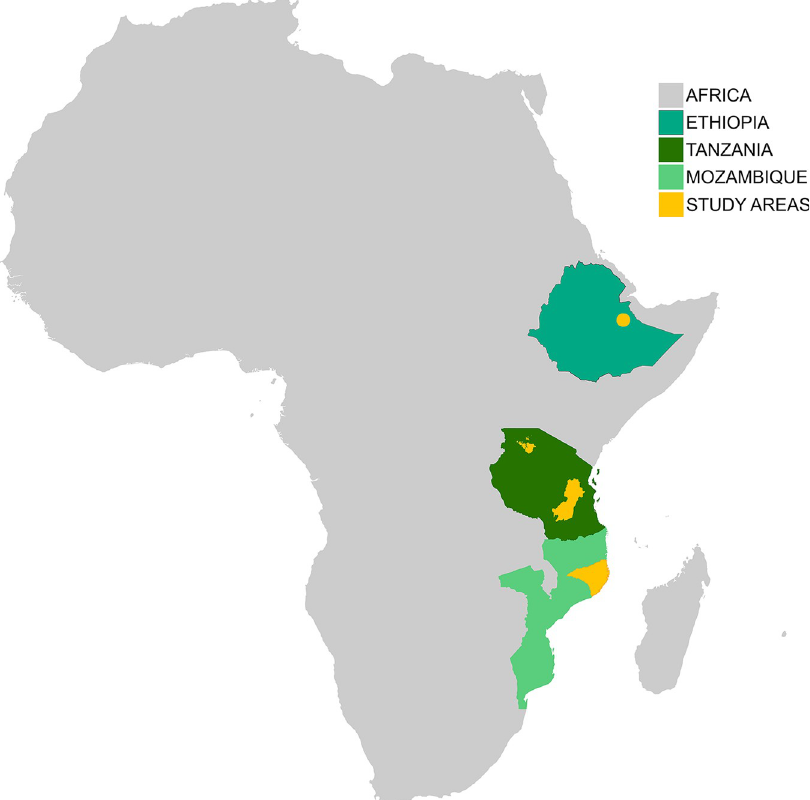
Fig 1. PEP4LEP study locations–created with ArcGIS Pro. Base layer of the map available via: https://www.arcgis. com/home/item.html?id=64aff05d66ff443caf9711fd988e21dd